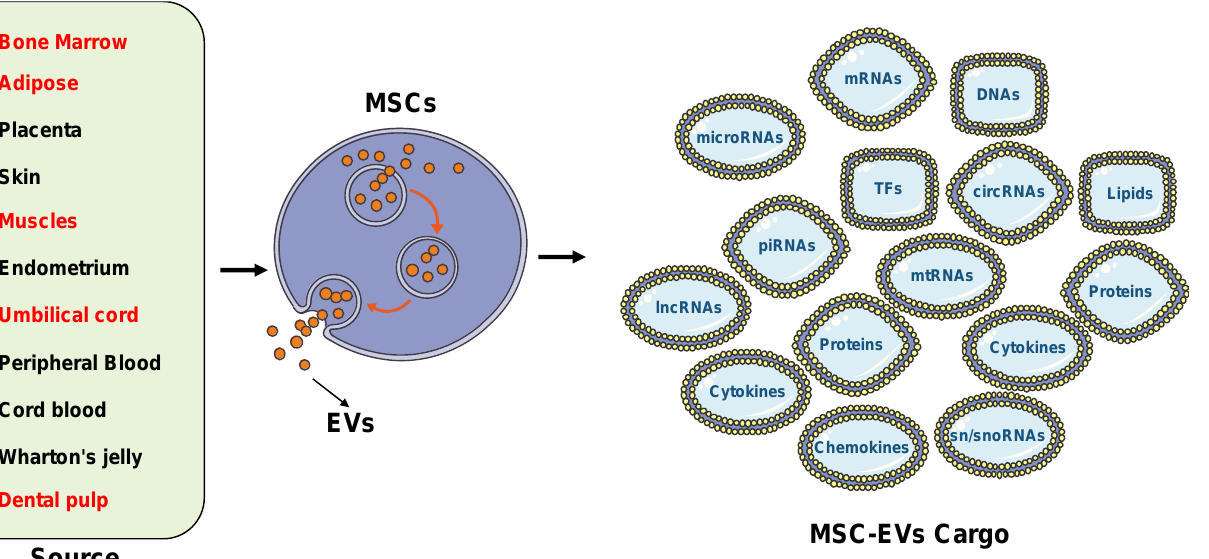
Figure 2. Schematic diagram of various sources of MSCs and their EVs that carrying cargo.